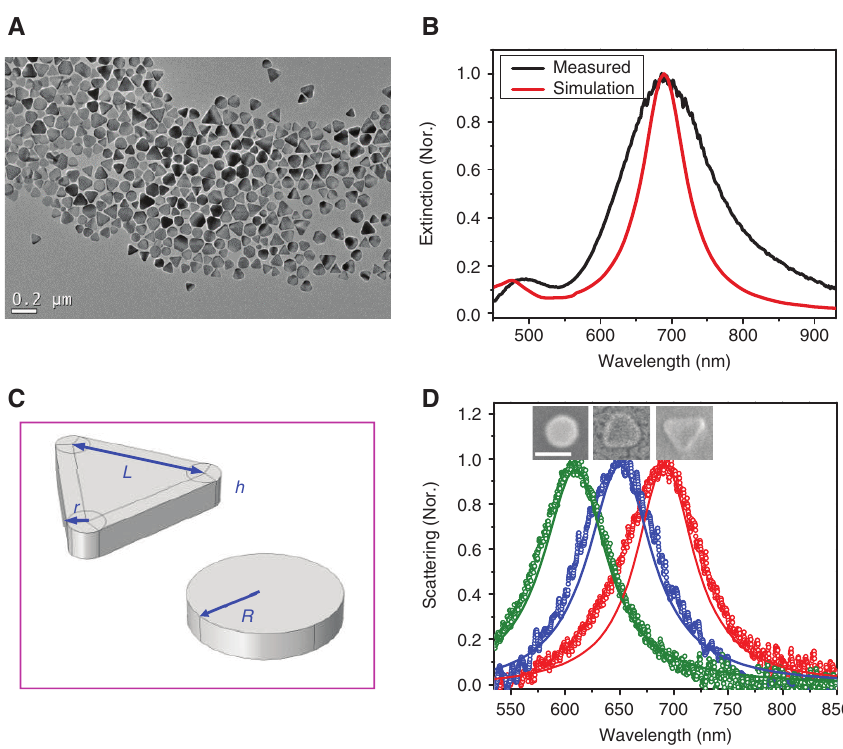
Figure 1: Characterization of Ag nanoplates. (A) A typical TEM image of the synthesized Ag nanoplates. Triangular, hexagonal, and circular shapes can be observed. (B) The black